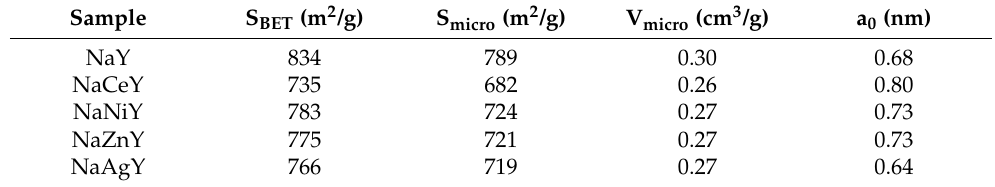
Figure 5. N 2 adsorption and desorption isotherms ( a ) and pore size distribution ( b ) of different Y zeolites. Table 3. Surface area, micropore volume and the most available pore size (a 0 ) of different Y zeolites.